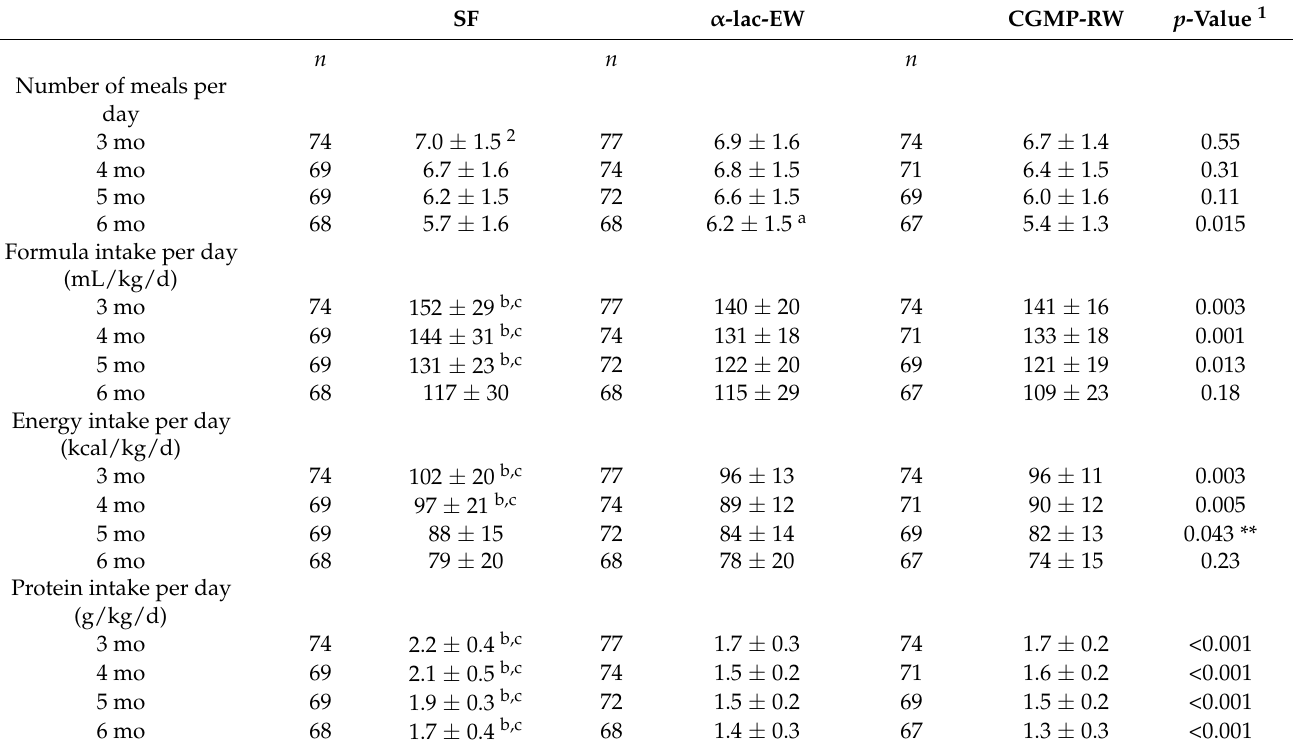
Table 3. Infant formula, energy and protein intake in infants fed formula (SF, α -lac-EW or CGMP-RW) * during the intervention, ITT